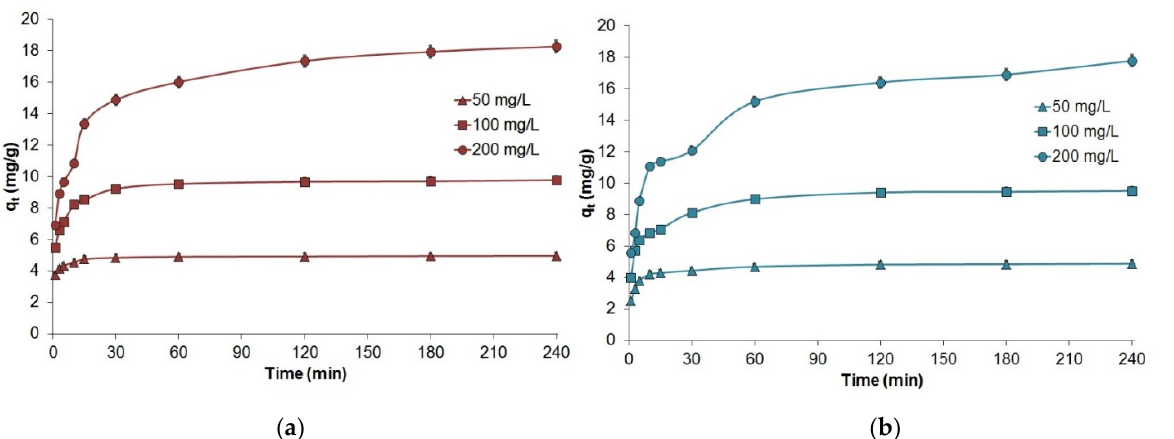
Figure 1. Adsorption of BB3 onto ( a ) sawdust and ( b ) Cladium mariscus saw-sedge a function of phase contact time and dye initial concentration.